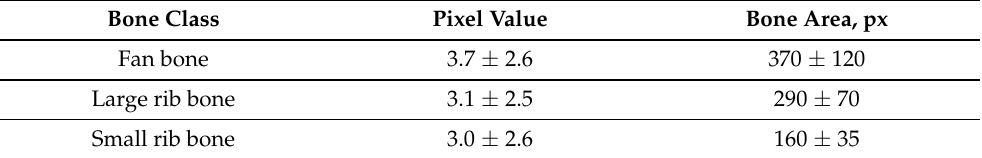
Table 1. Comparison of mean pixel intensity and foreign object sizes for different types of